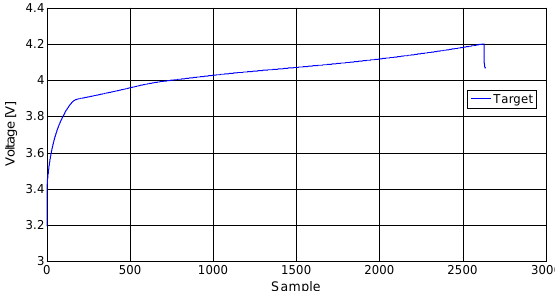
Figure 2. Voltage characteristics of a Li-Ion battery during charging (ICR18650PD, 1 sample/s).